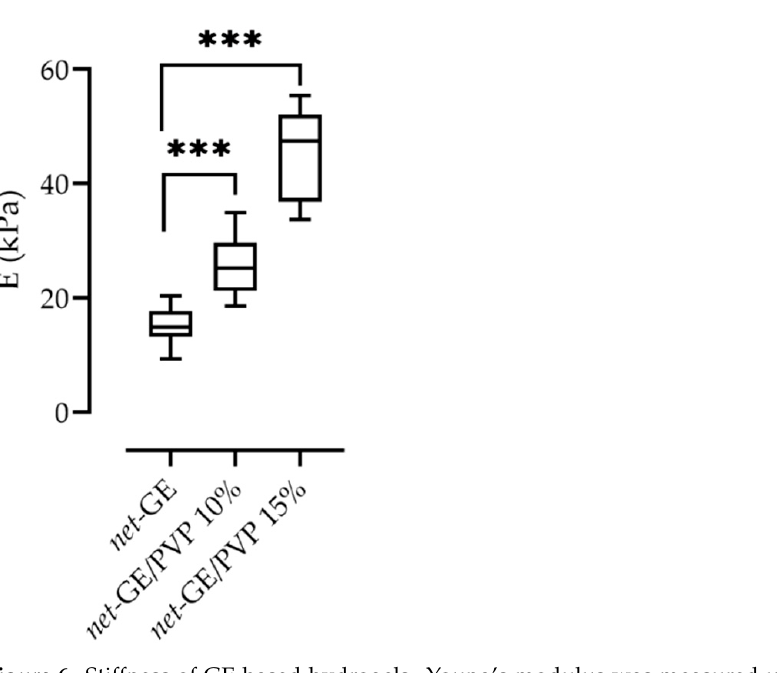
Figure 6. Stiffness of GE-based hydrogels. Young’s modulus was measured using a microindentation test and by fitting the Hertz model to the force–distance curves. A one-way analysis of variance (ANOVA) with Tukey correction was employed for multiple comparisons. It was considered statistically significant when p < 0.05; *** p <